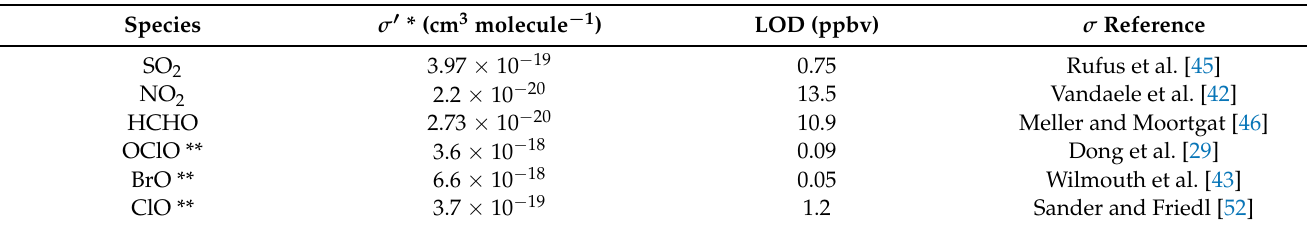
Table 1. Estimated limits of detection for a 5-min sampling time of atmospherically relevant species that absorb in the same wavelength range as SO 2